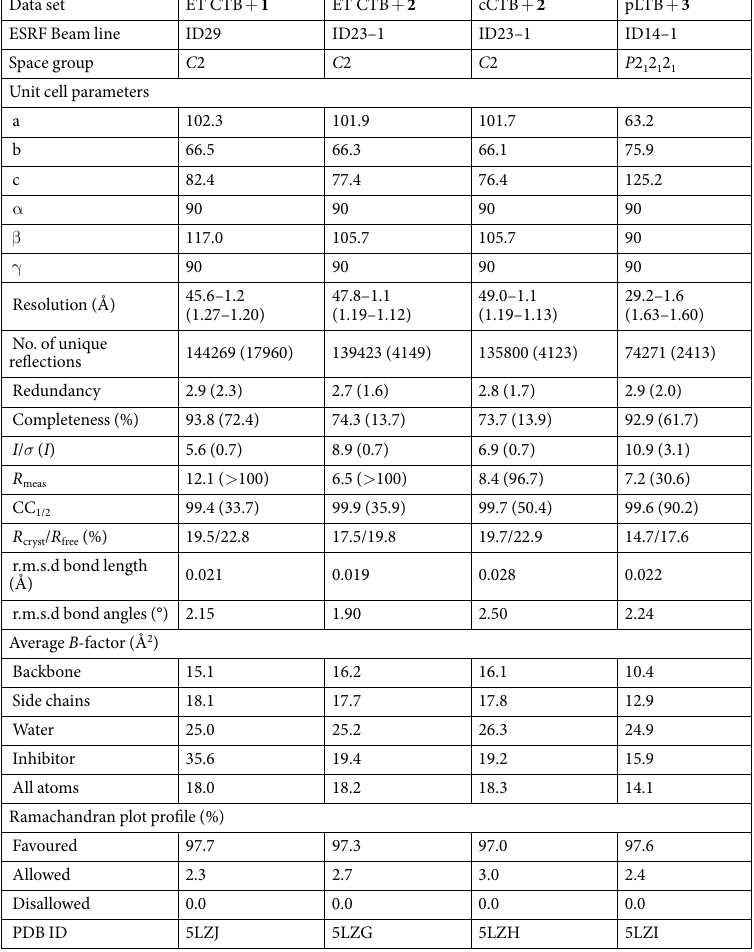
Table 1. Data collection and refinement statistics. Values in parentheses refer to the highest resolution shells.